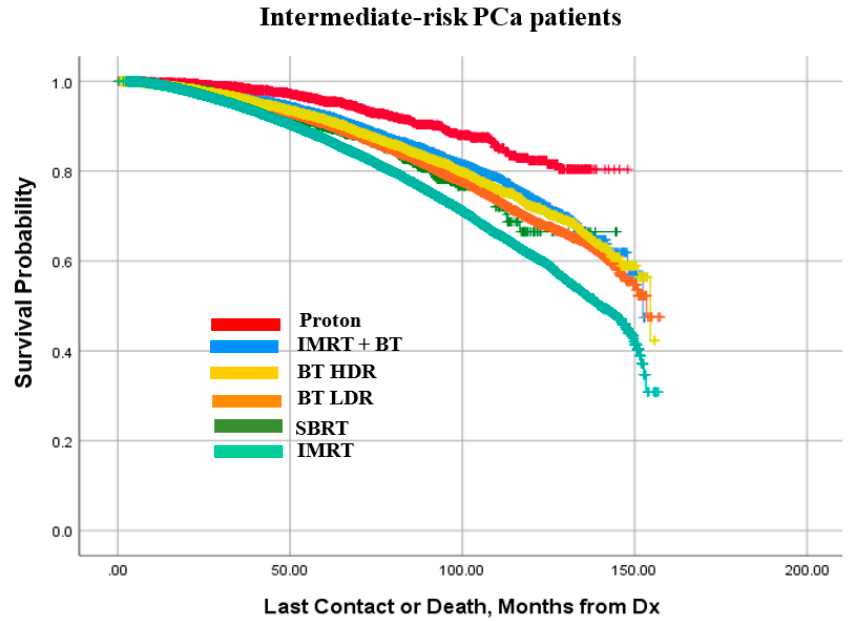
Figure 6. Kaplan–Meier curve for cumulative survival of intermediate-risk patient prostate cancer (PCa) patients treated with the compared modalities.